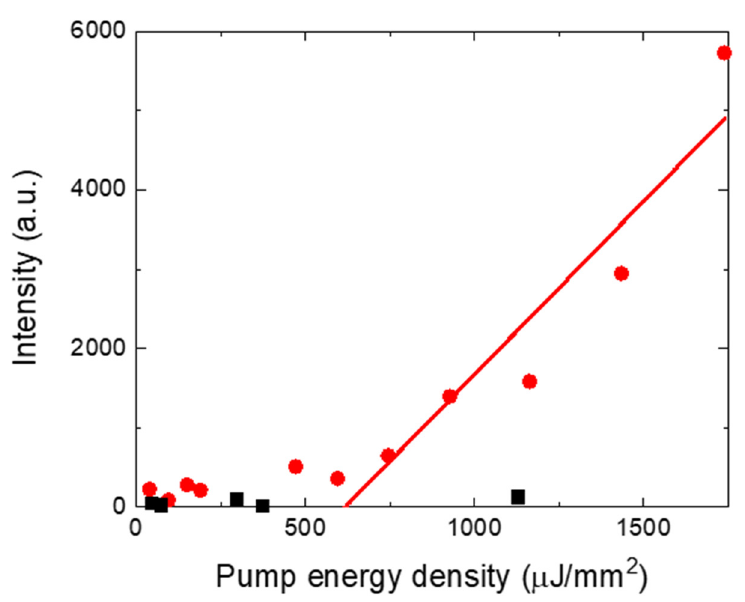
Figure 3. Spectrally integrated laser emission intensity as a function of pump energy density. Red dots indicate the target DNA laser emission, while black squares are from base mismatched DNA.